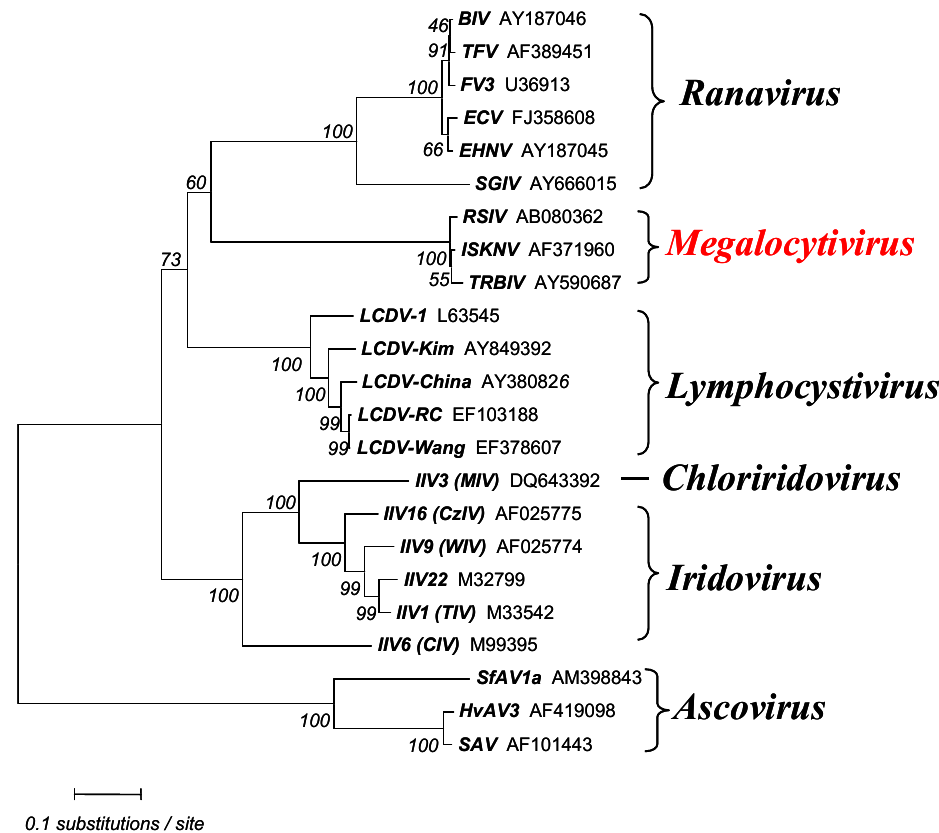
Figure 4. Iridovirus phylogeny. The tree was constructed based on amino acid sequences of the major capsid protein (MCP) by the neighbor-joining method [43] using